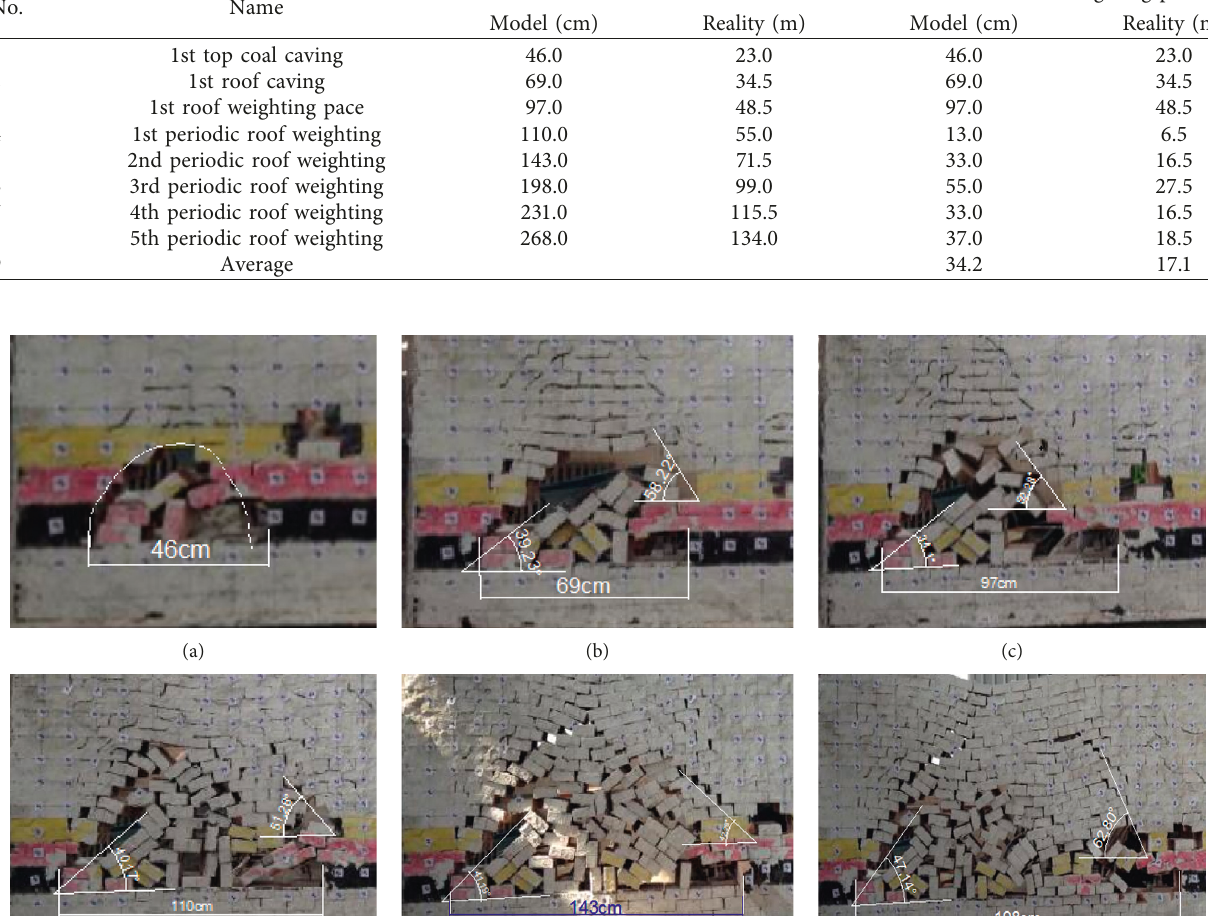
Table 1: The statistics of top coal, immediate roof, and main roof collapsing interval of 10 cm (5m) interlayer. No.